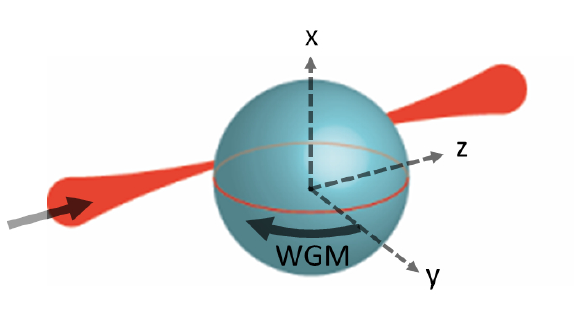
Figure 1. Schematics of a direct WGM excitation. An incident beam propagating along the z axis is displaced a distance d in the y axis, and it tangentially hits the microresonator. As a result, a WGM that oscillates around the x axis is